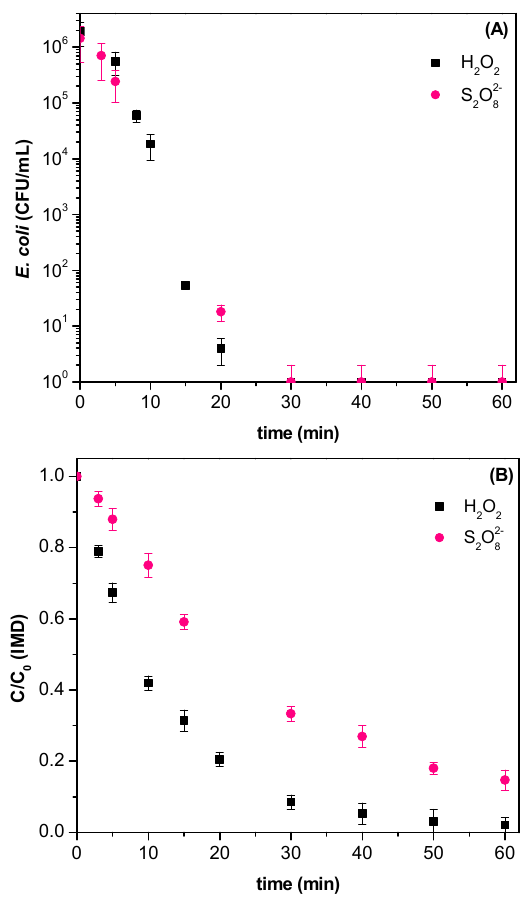
Figure 6. Simultaneous E. coli inactivation ( A ) and IMD removal ( B ) by UVC-LED/Fe 3+ –NTA/H 2 O 2 and UVC-LED/Fe 3+ –NTA/S 2 O 82 − systems. Operating conditions were: 0.10 mM of Fe 3+ –NTA complex at a 1:1 molar ratio, and 1.47 mM of each of the oxidants under study (H 2 O 2 and S 2 O 82 − ). Concerning IMD removal, as shown in Figure 6B, more than 80% degradation was achieved with both treatments. The UVC-LED/Fe 3+ –NTA/H 2 O 2 system needed 20 min with a kinetic constant of 0.081 ± 0.001 min − 1 (UVC-LED dose of 2.4 kJ/m 2 or 0.05 kJ/L, Table 1), while for the UVC-LED/Fe 3+ –NTA/S 2 O 82 − system 55 min were required, presenting a lower kinetic constant equivalent to 0.033 ± 0.001 min − 1 (UVC-LED dose